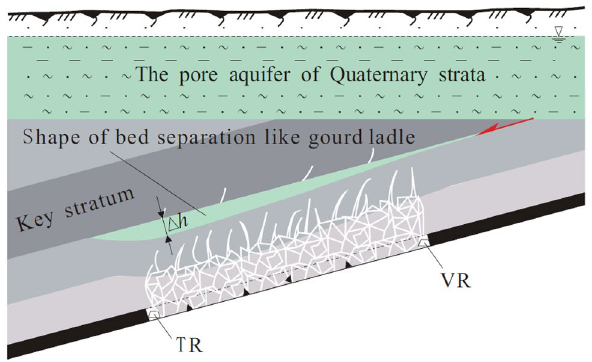
Fig. 2 Diagram of bed separation when mining on inclined coal seam